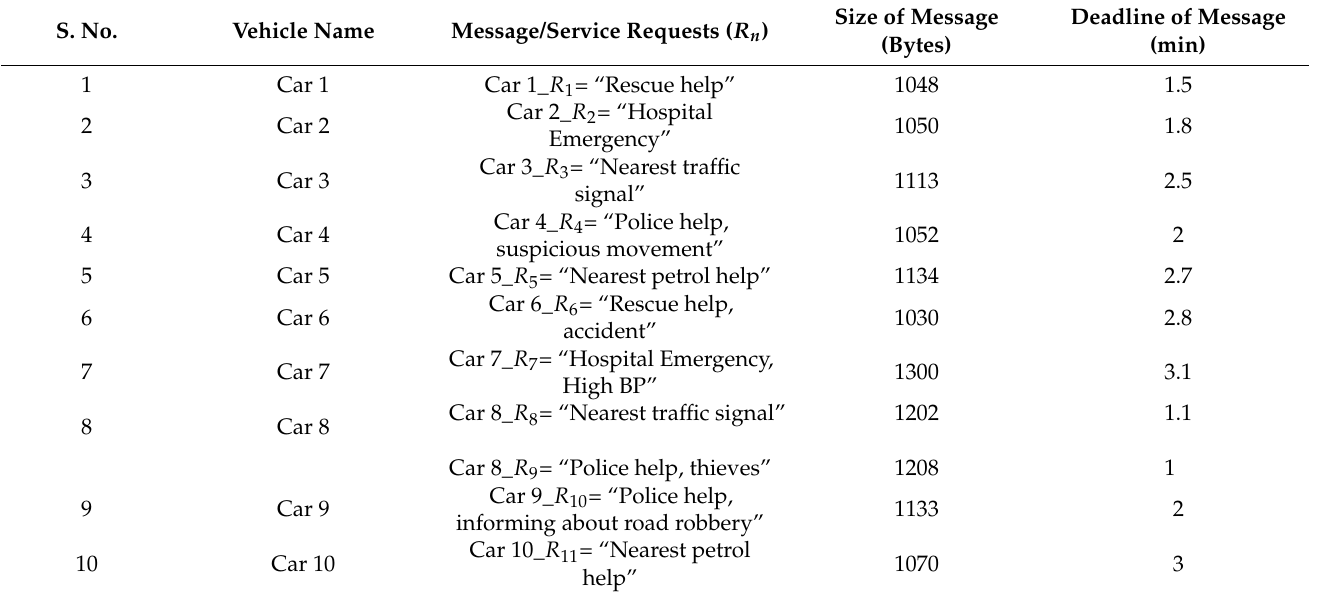
Table 2. Ten vehicles messages that want to send.